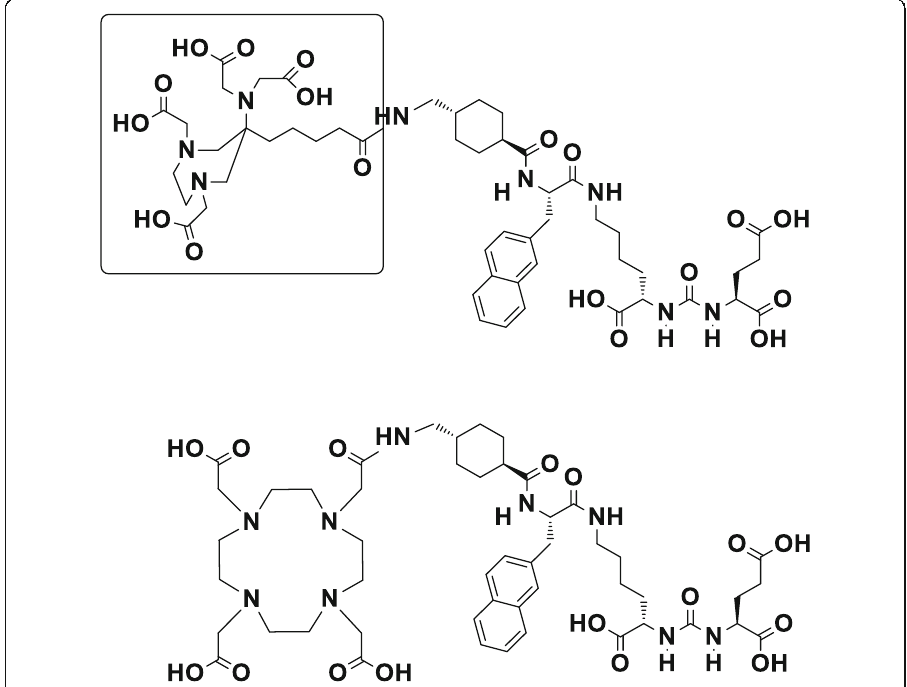
Fig. 1 AAZTA 5 -PSMA-617 and DOTA-PSMA-617, AAZTA 5 -chelator